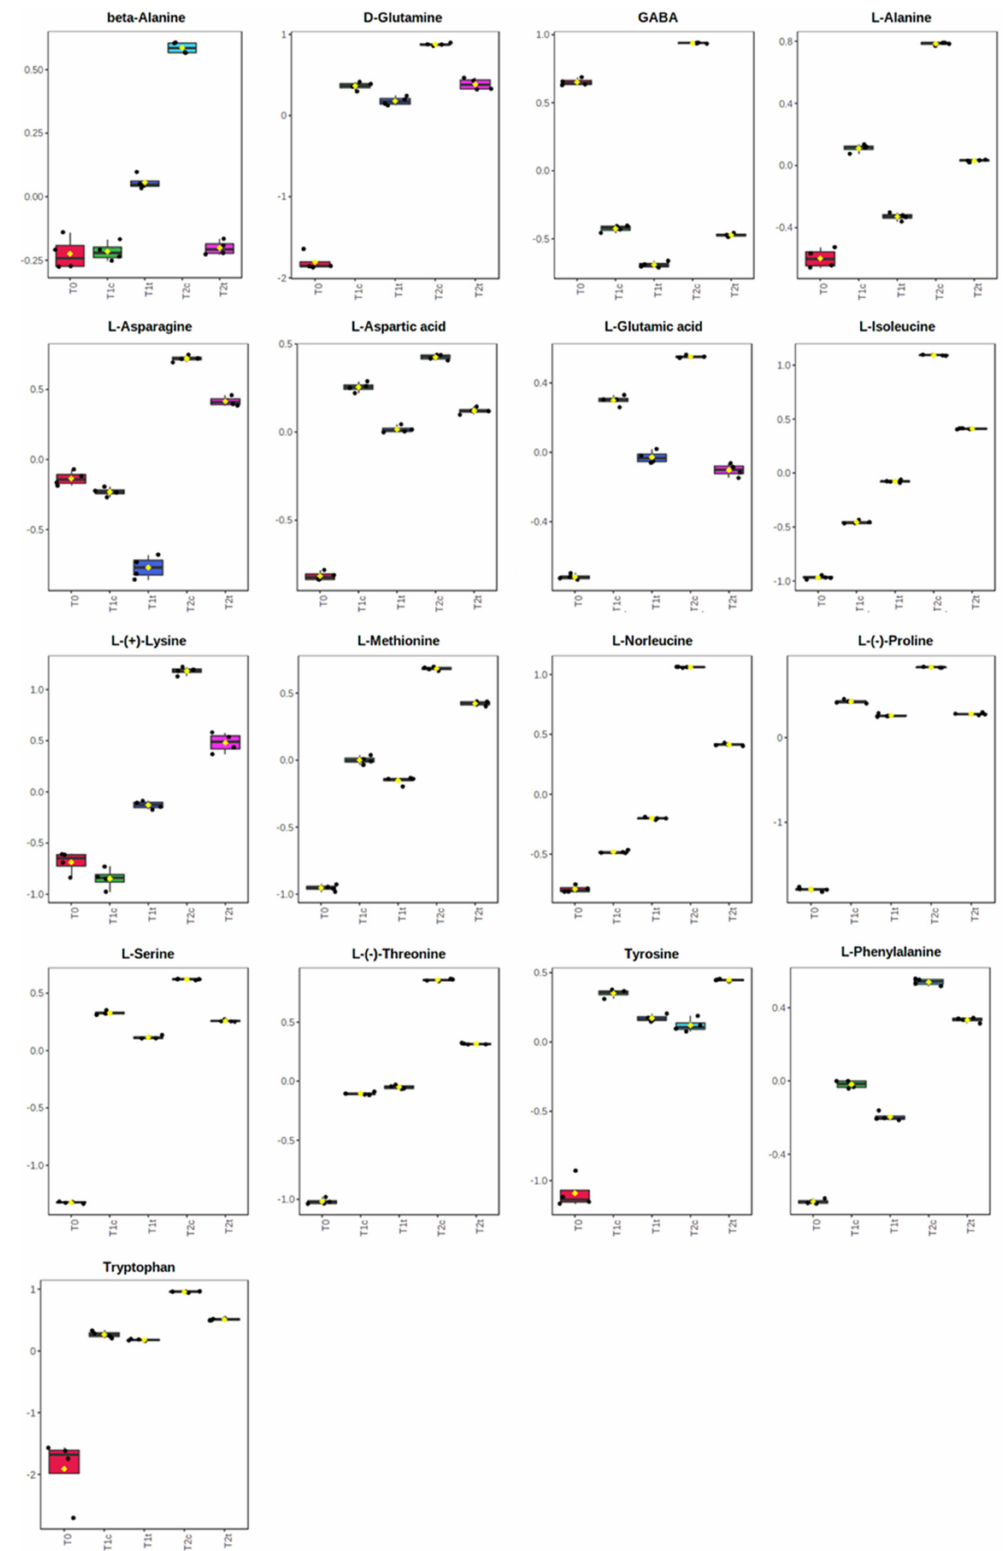
Figure 7. Effects of 0 h, 24 h, and 48 h of coumarin treatment (400 µ M) on the contents in R. sativus seeds from amino acids pool. Normalised metabolomic data were analysed through ANOVA using the LSD test as post hoc ( p ≤ 0.05). N = 4. For the full list of the significantly altered metabolites, refer to Supplementary Table